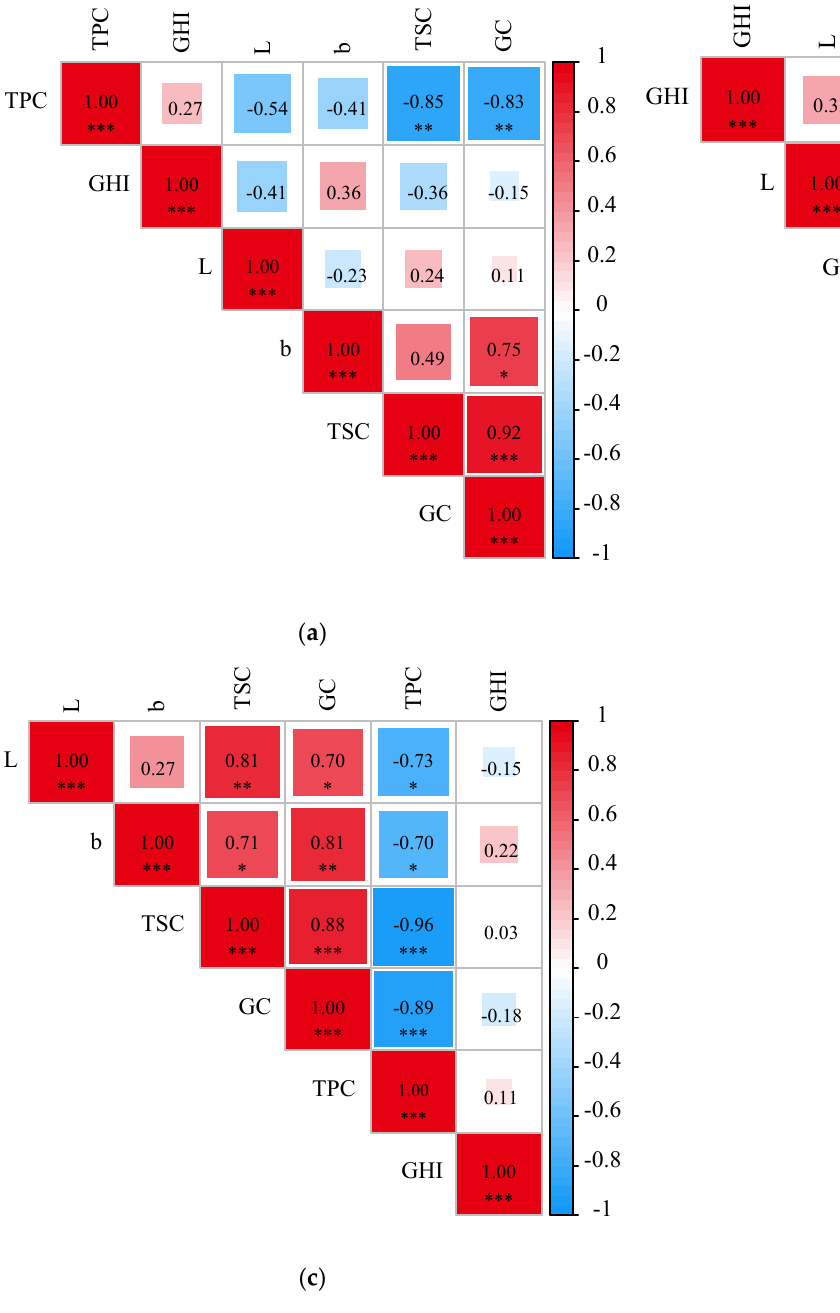
Figure 5. Correlation analysis between different environments and quality traits. a:E1, b:E2, c:E3. (b: b value of grain color; L: L value of grain color; GC: gel consistency; TPC: total protein content, TSC: total starch content, GHI: grain hardness index) . Note: * represents a p value < 0.05 by Duncan’s test; ** represents p < 0.01, *** represents p < 0.01.